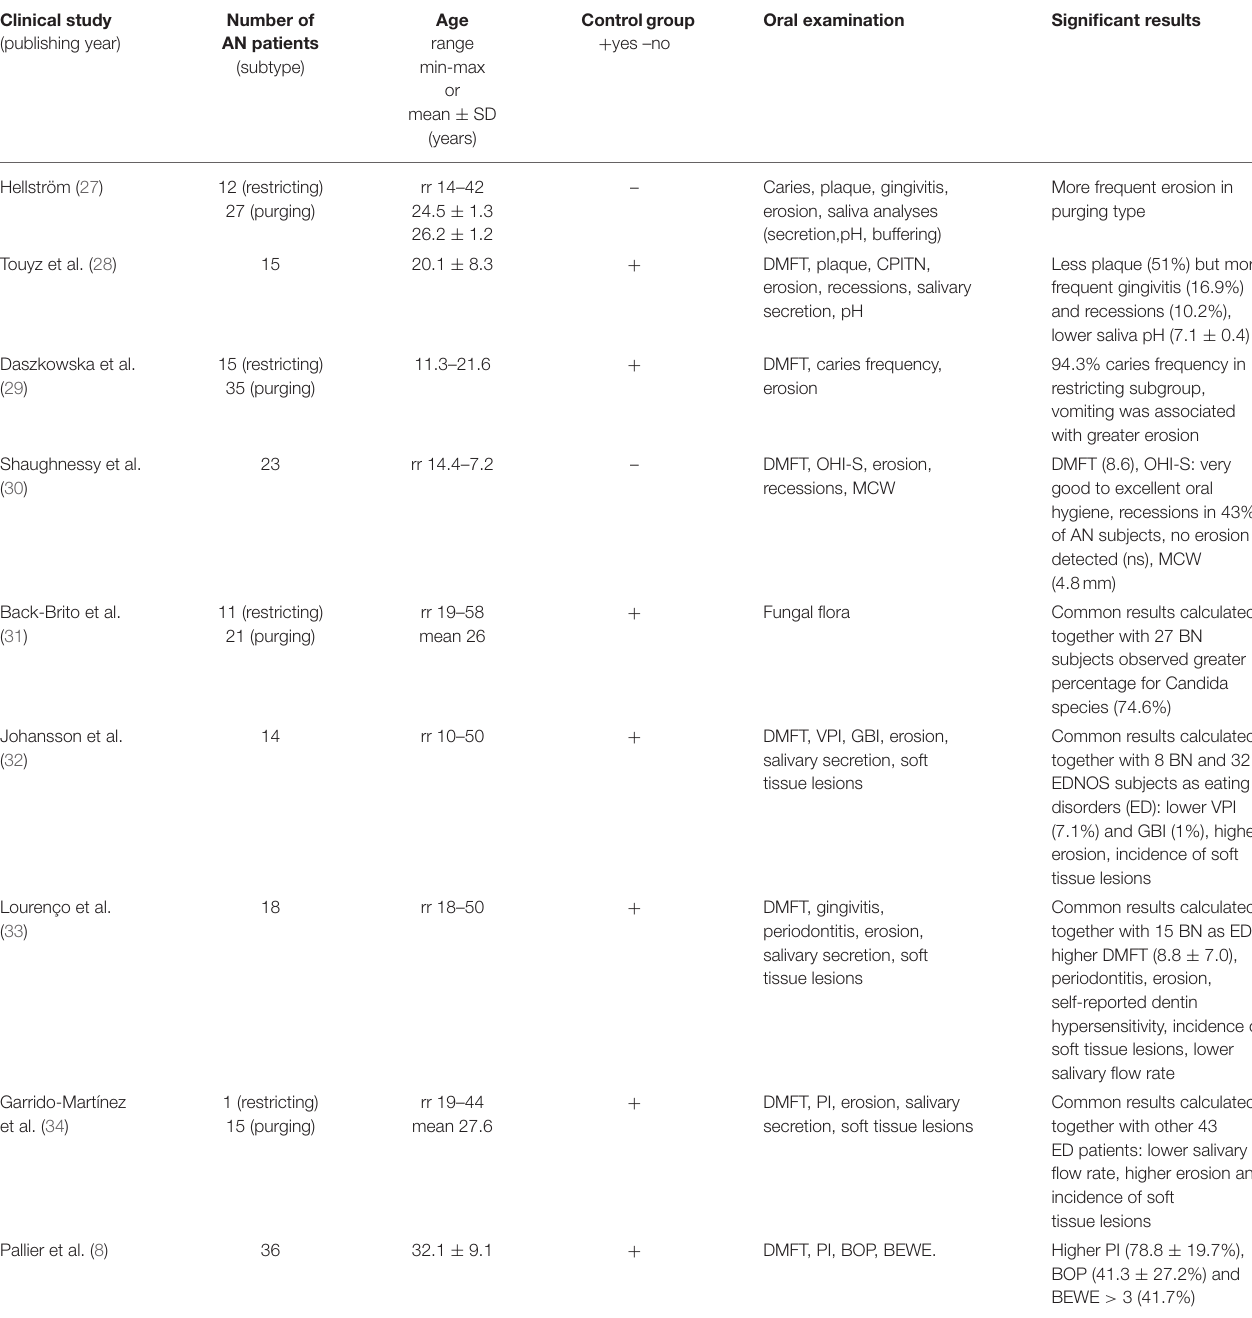
TABLE 4 | A synthesis of data obtained from the electronic research organized in PubMed database and Web of Science. Clinical study (publishing